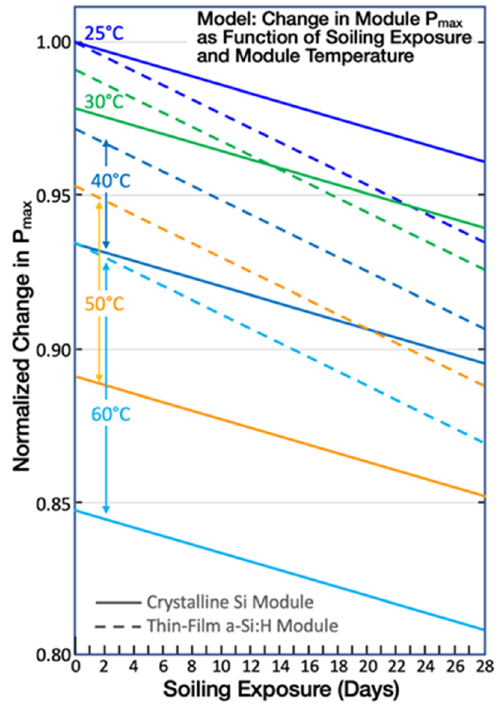
Figure 11. Model prediction of normalized change in P max as function of soiling exposure days for various module temperatures, comparing Si with thin-film a-Si:H module.